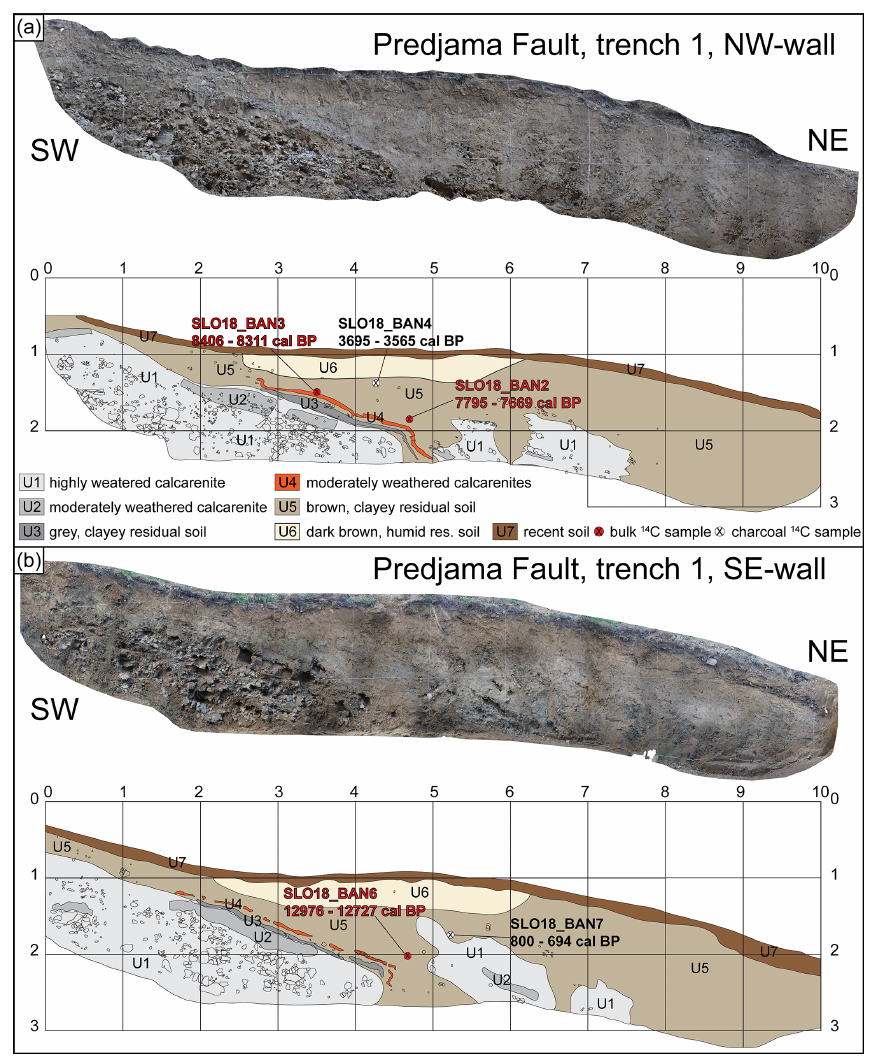
Figure 8. Paleoseismic trench 1 across the Predjama Fault on the Banjšice Plateau. (a) NW wall of the trench. The fault crosses the trench at ∼ 5m distance. Note the folded units U3 and U4. (b) SE wall of the trench. The fault crosses the trench between 4m and 5m